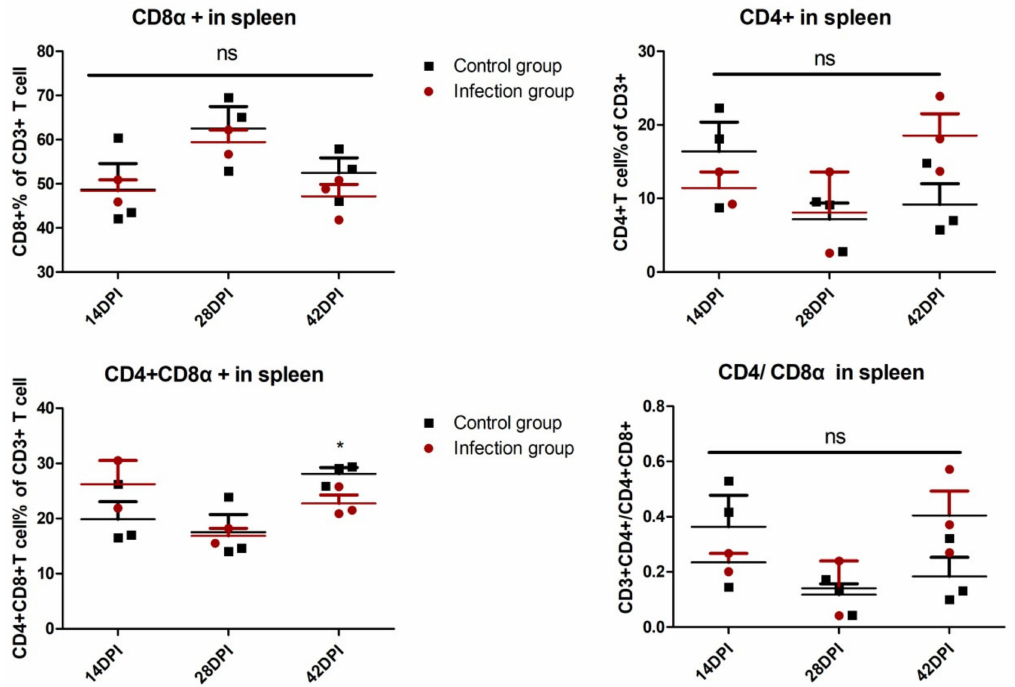
Figure 4. Analysis of T lymphocyte percentage in spleen. Spleen single-cell suspensions derived from chickens of infected and control groups were isolated to detect the T lymphocyte percentage. Every dot stands for one chicken. The unpaired t-test was used for statistical comparison. ns p > 0.05, * p < 0.05.. Each sample collected 2 × 10 5 cells for flow cytometric